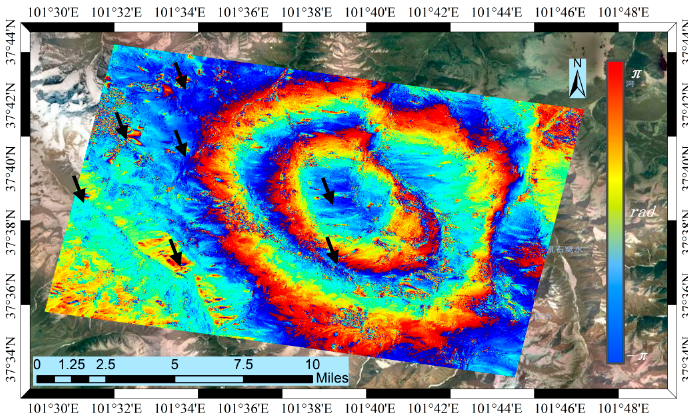
Figure 3. Differential interferogram showing the deformation of the Menyuan earthquake. The interferogram is superimposed on an optical image, with one full color cycle representing a difference in phase of 2 π corresponding to 2.8 cm of the LOS (Line Of Sight) range change. It was generated using two descending Sentinel-1A IW mode images acquired before (18 January 2016) and after (11 February 2016) the M S 6.4 Menyuan earthquake (21 January 2016).